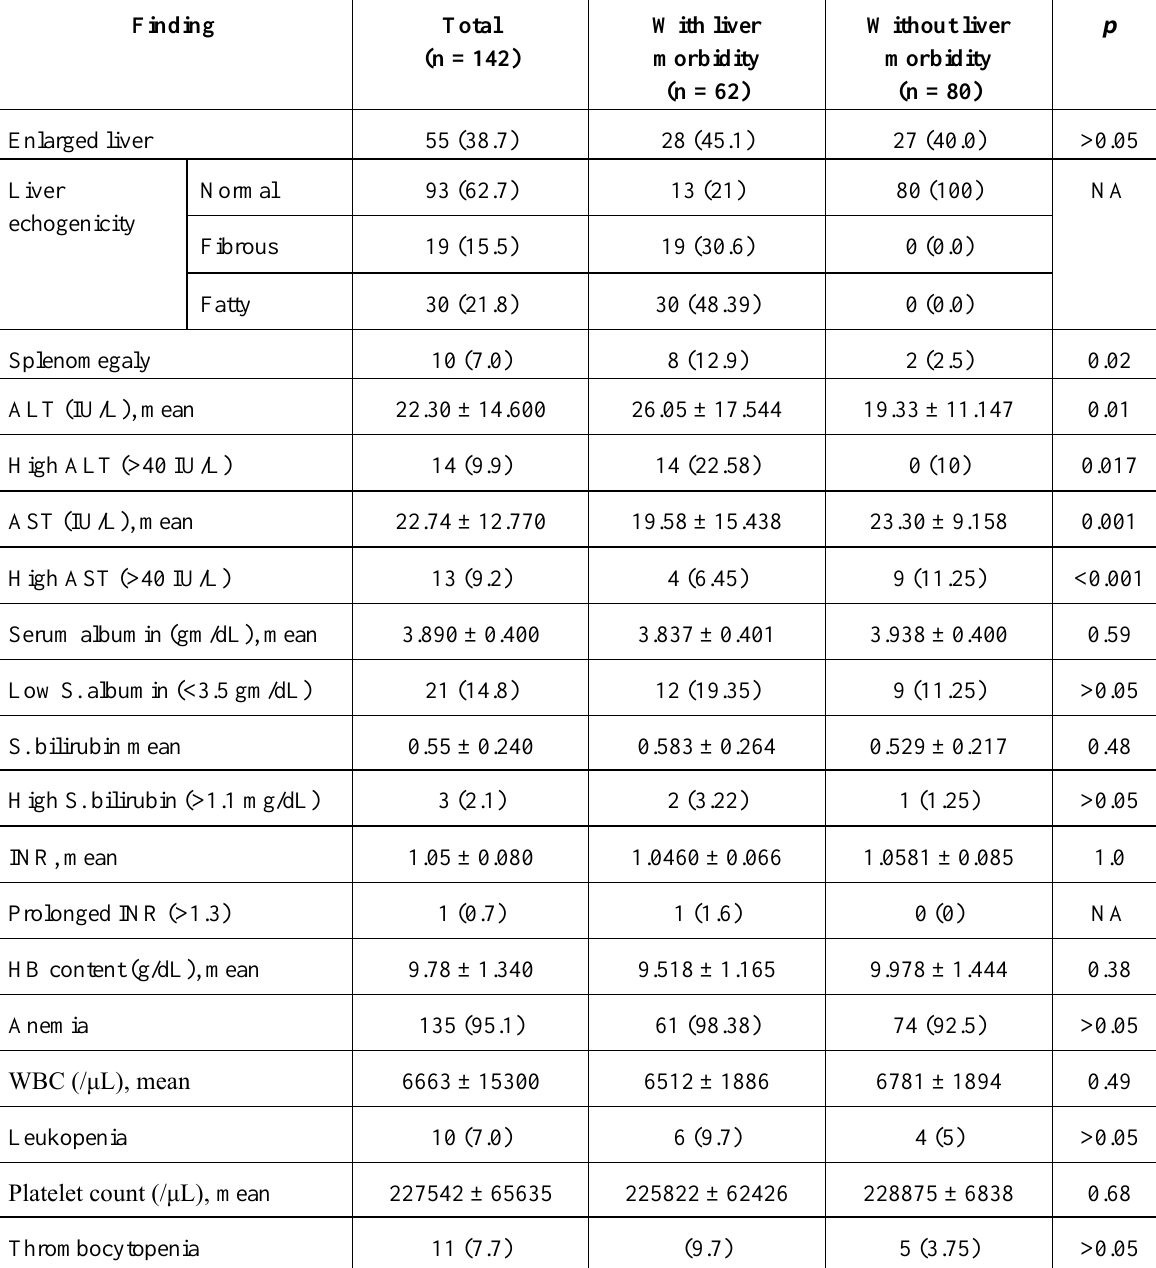
Table 2. Analysis of liver morbidity manifestations among 142 studied subjects on regular hemodialysis.